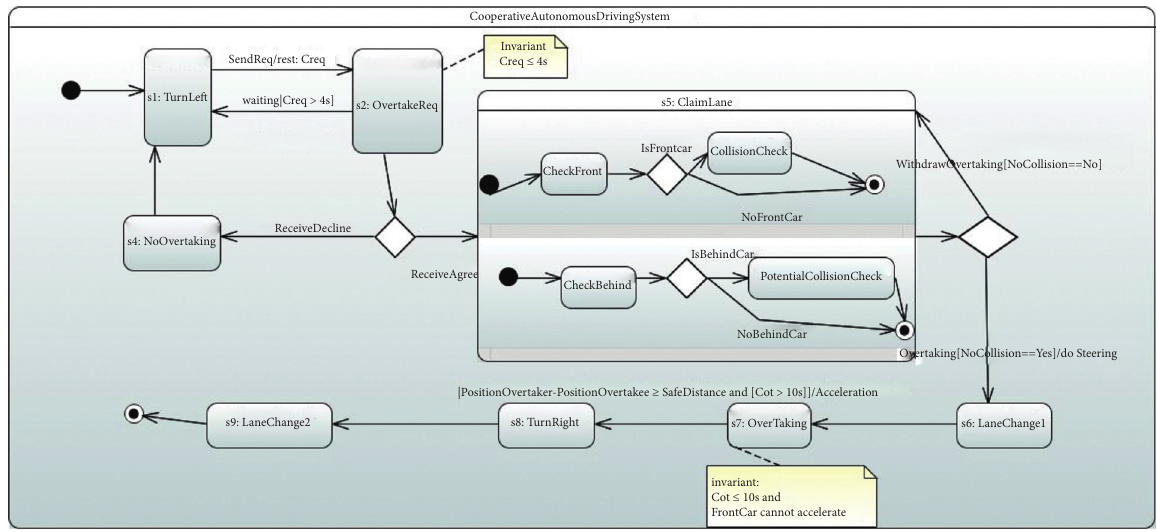
Figure 8: SMD for the autonomous overtaking